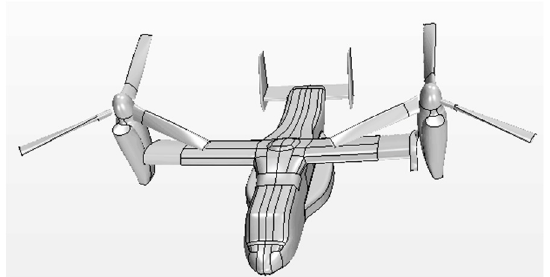
Figure 1. Geometric modeling of the V-22 tiltrotor. Table 1. Geometric details of the 0.658-scale V-22 model [5].